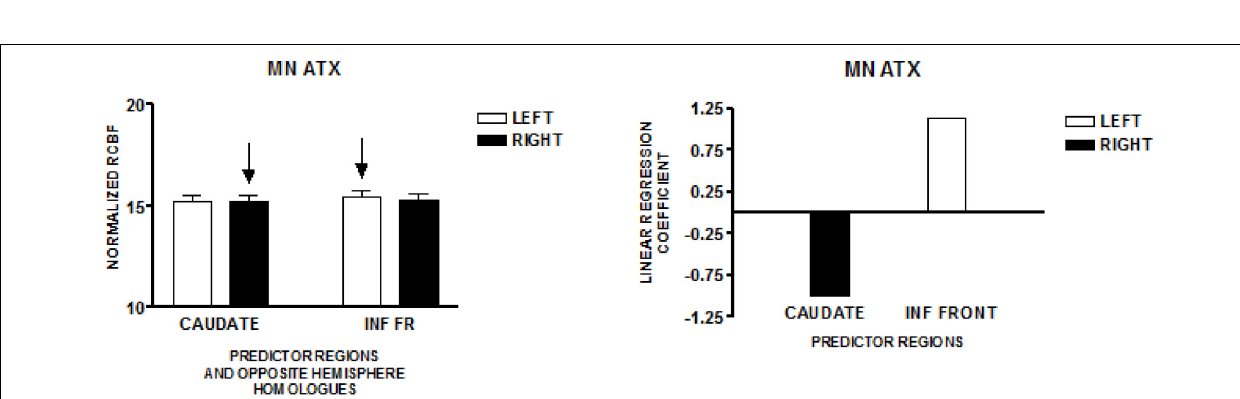
FIGURE 3 | The results from a comparable speech production study in a group of individuals with hereditary spino-cerebellar ataxia using the same protocol employed in the study of normal volunteers in Minnesota (MN). The graph on the left presents the mean normalized rCBF ( ± SEM) for the head of the caudate nuclei, and the inferior frontal region, bilaterally. Neither homologous pair has a significant left–right difference. The regions that predict speech rate are indicated by arrows. The graph on the right presents the linear regression weights for the two regions that predict speech rate (Sidtis et al., 2006).